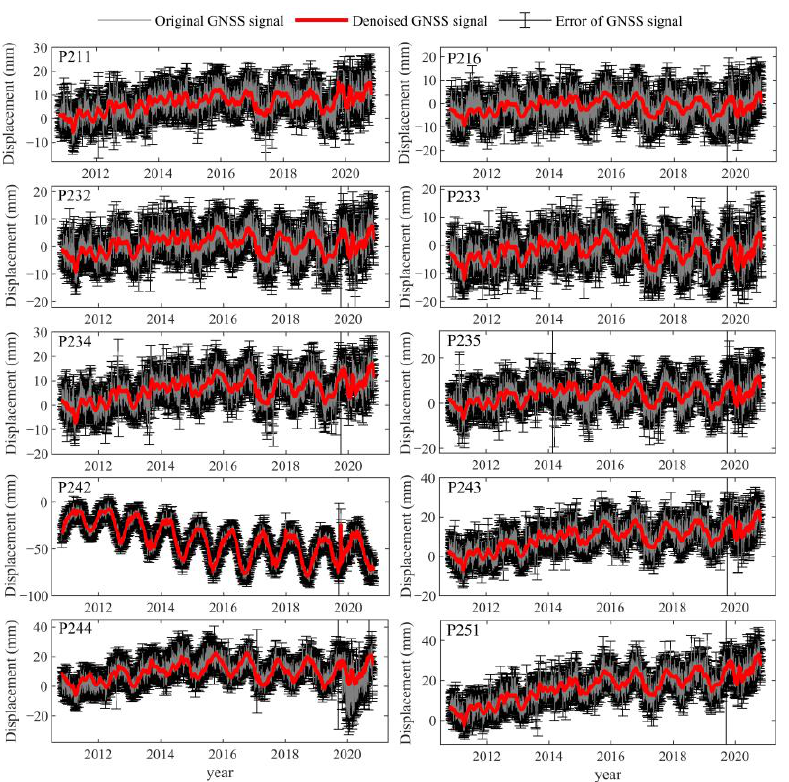
Figure 6. Effect of the proposed denoising method in U direction for Block 1. Grey lines denote original GNSS daily time series; red lines denote denoised GNSS daily time series; and black I-shapes indicate errors corresponding to GNSS positions.